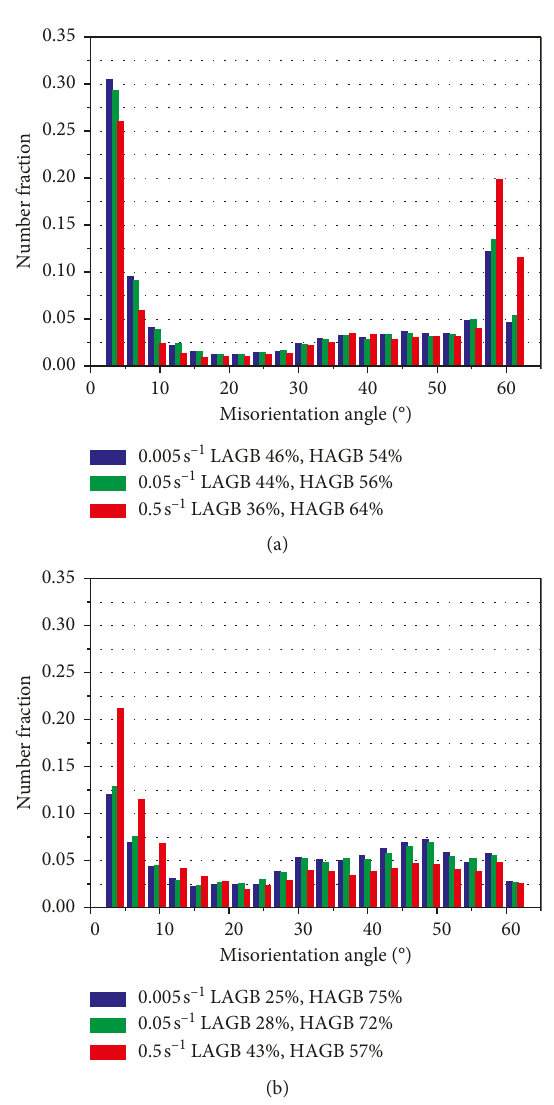
Figure 5: Distribution of misorientation angles in (a) austenite and (b)